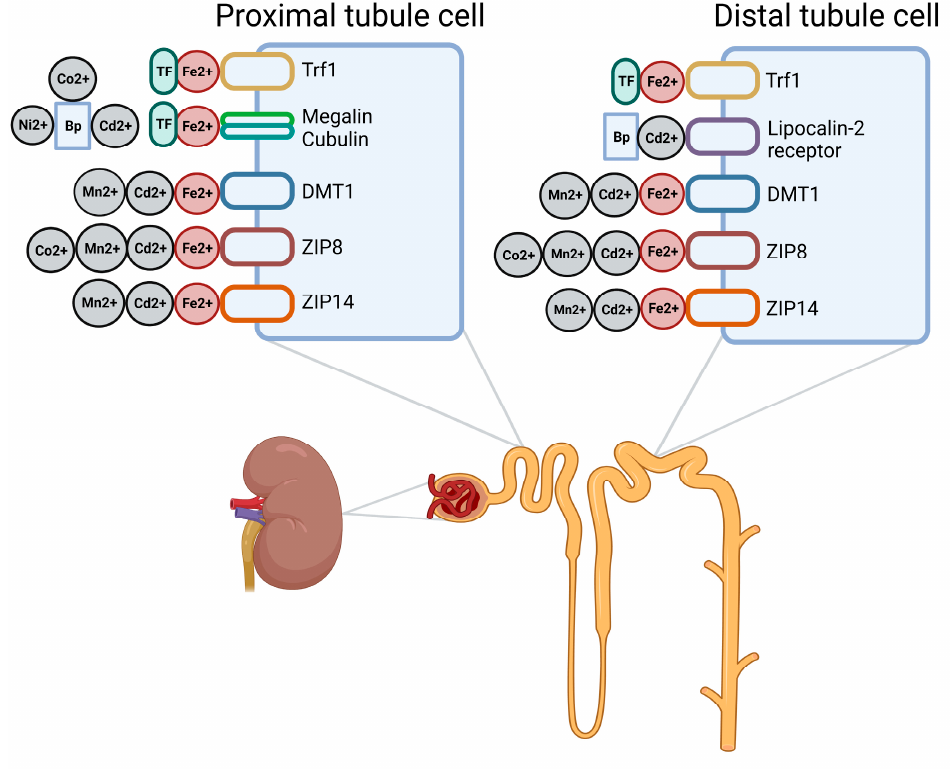
Figure 2. Overview of transporters suggested to be involved in the renal reabsorption of iron and other (toxic) metals. TF: transferrin. Trf1: transferrin receptor 1. Bp: binding protein, referring to different metal binding proteins, e.g., β 2-microglobulin and albumin. DMT1: divalent